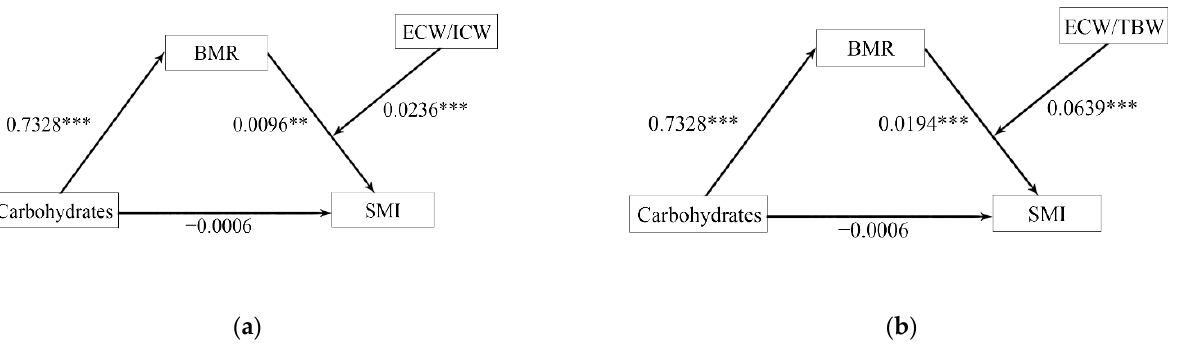
Figure 4. The moderated mediation models of BMR and body water distribution while controlling for age. ( a ) ECW/ICW; ( b ) ECW/TBW. a×b: Indirect effect; c: total e ffect; c’: direct effect; c = c’ + a×b. BMR, basal metabolic rate; TBW, total body water; ICW, intracellular water; ECW, extracellular